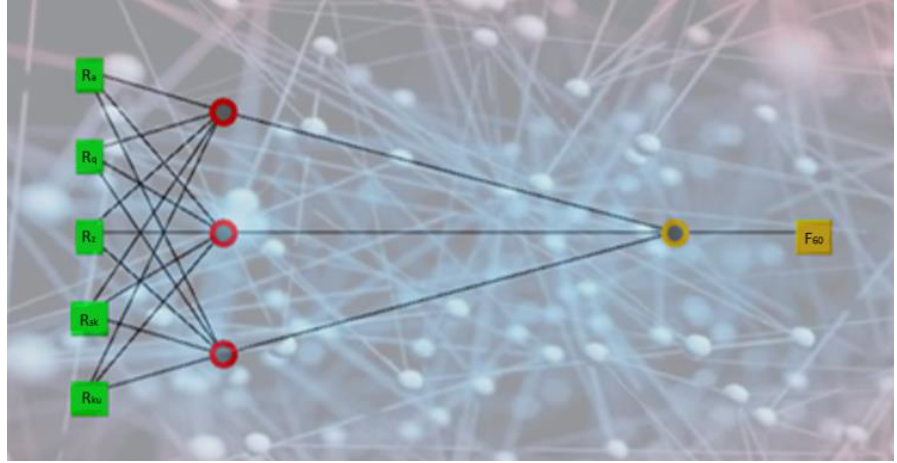
Figure 8. Schematic diagram of BP neural network model. Table 8. Calculated model weights with F 60 as the output node.